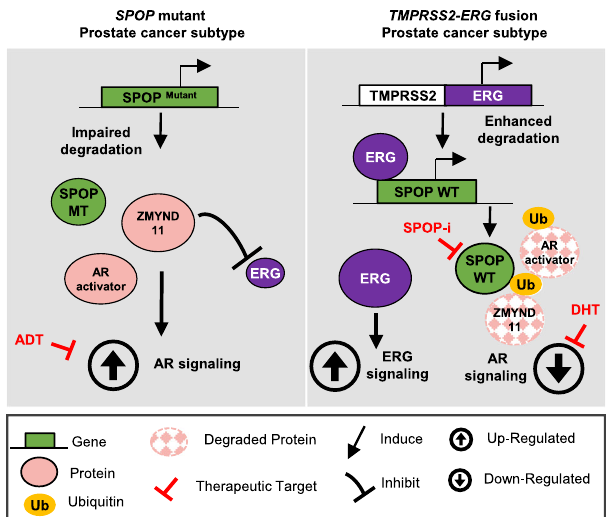
Fig. 10 Schematic representation of the proposed model for the aversive relationship between mutant SPOP and ERG in prostate cancer. On the left side, SPOP mutant prostate cancer tumorigenesis is depicted. SPOP mutant tumors impair the degradation of substrate proteins such as AR activators (e.g, TRIM24) and ZMIND11, which ultimately triggers the AR pathway and dampens the ERG signaling. In this context, SPOP mutant tumors are more susceptible to ADT therapy. On the right side, TMPRSS2- ERG mutant tumorigenesis is depicted. ERG binds to the promoter of wild- type SPOP, upregulating its protein expression. Consequently, AR activators and ZMYND11 substrate proteins get degraded, leading to the AR pathway downregulation and unleashing the ERG signaling pathway. TMPRSS2-ERG mutant tumors are thus sensitive to high-dose androgen therapy or SPOP